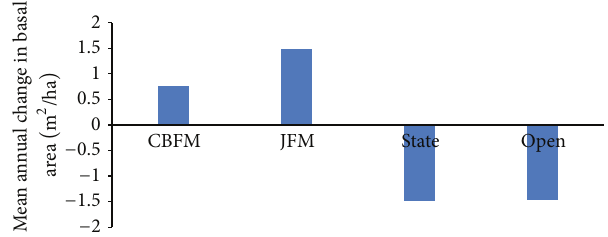
Figure 2: Compared growth patterns of miombo woodlands under PFM and non-PFM in Tanzania. Source: Blomley et al.